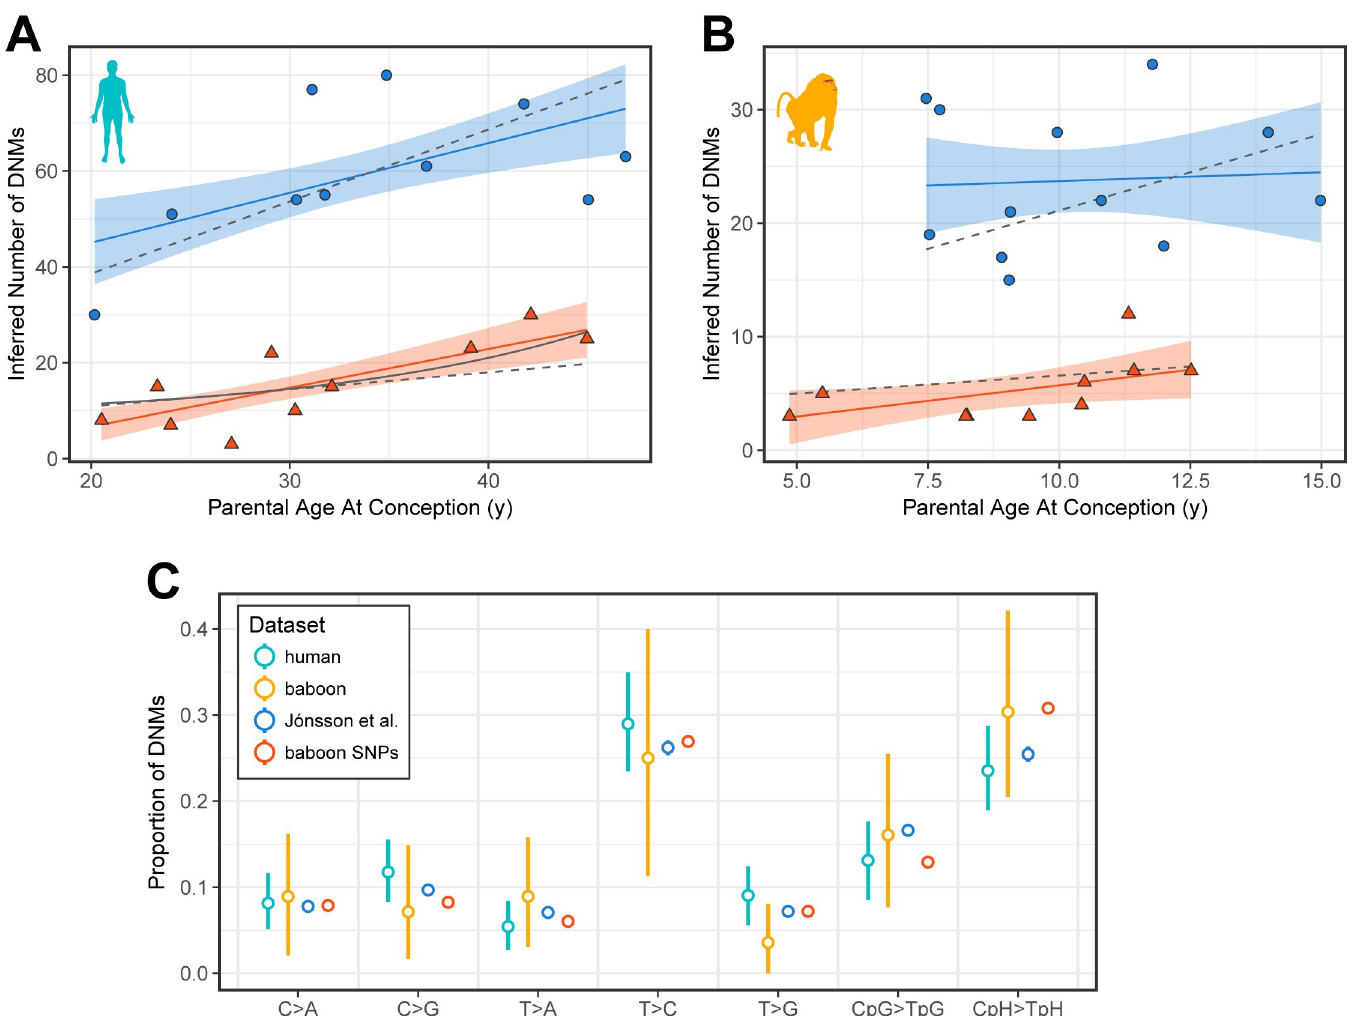
Fig 2. Dependence of mutation count on sex and age. Each human (in A) and baboon (in B) F 1 individual is represented by a blue circle and a red triangle, which indicate how many DNMs were estimated to have occurred on the paternal or maternal genomes, respectively. Maternal points for 2 baboons were omitted because of a lack of information about the age of the mothers. Solid blue and red lines indicate the best fit obtained from a Poisson regression for each sex, respectively. Blue- and red- shaded regions denote the 95% CIs associated with the regression coefficients. Gray dashed lines represent the sex-specific fits from Gao and colleagues [32], scaled to account for differences in genome size in [32] versus this study. In (A), the solid gray line denotes the exponential maternal age effect fit from Gao and colleagues. We did not find a significant difference between the parental slopes of the 2 species (LR test p -value = 0.19 in fathers, 0.37 in mothers). (C) Human and baboon mutation spectra, in our sequenced cohorts and previously published datasets. Spectra are shown for all transmitted DNMs in humans (teal); all transmitted baboon DNMs (orange); DNMs called in a large set of Icelandic 3-generation pedigrees [17] (blue); and low-frequency SNPs (doubleton and tripleton alleles) identified in a sample of distantly related baboons (red). Each point denotes the relative proportion of mutations that belong to 1 of 7 types of mutations, as indicated on the x-axis; reverse complement mutation types were collapsed together into a single type (e.g., the left-most column, C > A, includes G > T mutations). Transitions at cytosine sites were separated into those that occurred at a CpG (CpG > TpG) or a non-CpG (CpH > TpH) site. For all datasets, only DNMs and SNPs located within regions of the genome determined to be orthologous between humans and baboons were included. Vertical lines represent 95% CIs from bootstrap resampling of 50 cM blocks. CIs on the 2 reference datasets (blue and red) were constructed by bootstrap resampling of mutations but are small and hidden by the points. Underlying data for this figure can be found in S2 Data. cM, centimorgan; CpG, 5 0 -cytosine-phosphate-guanine-3 0 ; DNM, de novo mutation; LR, likelihood ratio; SNP, single-nucleotide